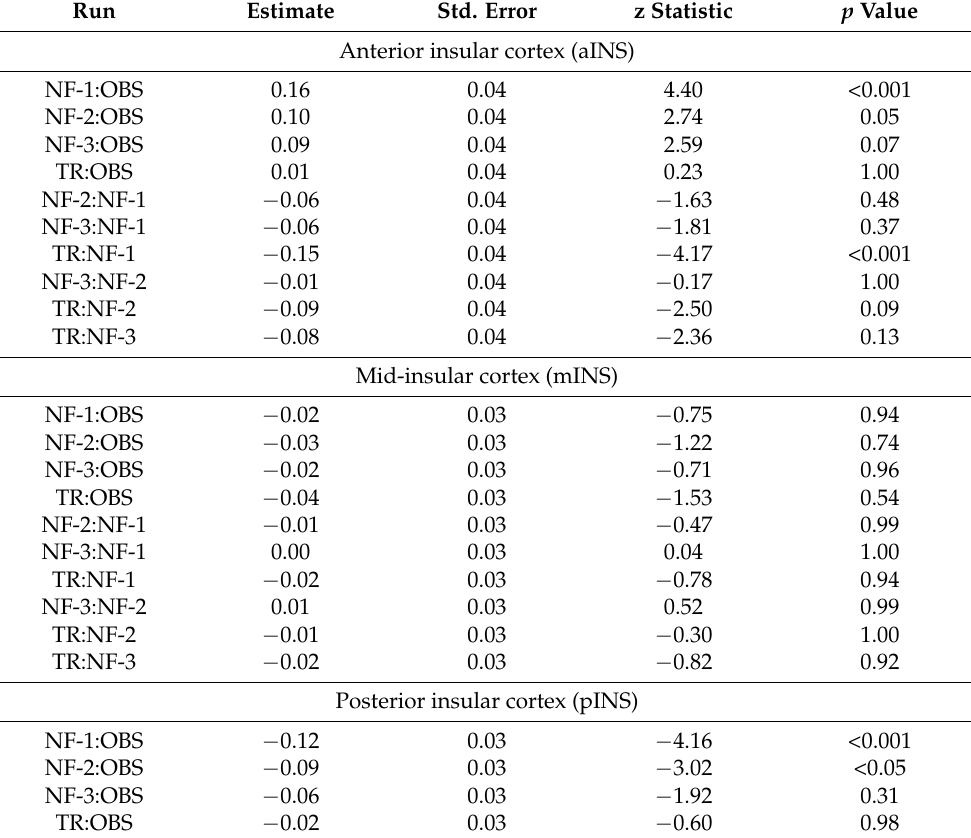
Table A4. Post hoc comparisons for parameter estimate (Focus-on-Breath vs. Rest) in insula subre- gions across